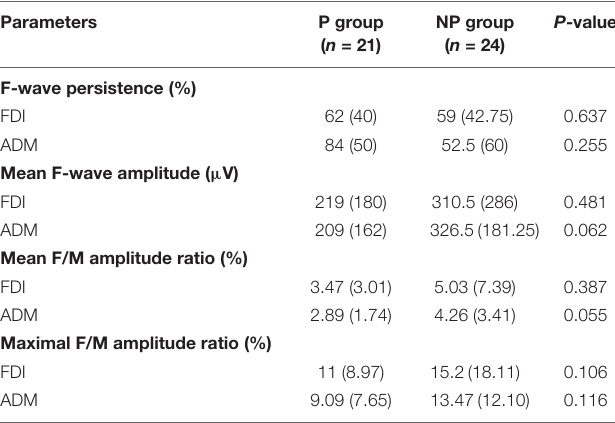
TABLE 4 | Comparison of F-wave parameters in ALS patients with split-hands between subgroups of those with (P) and without (NP) pyramidal signs. Parameters P group ( n =